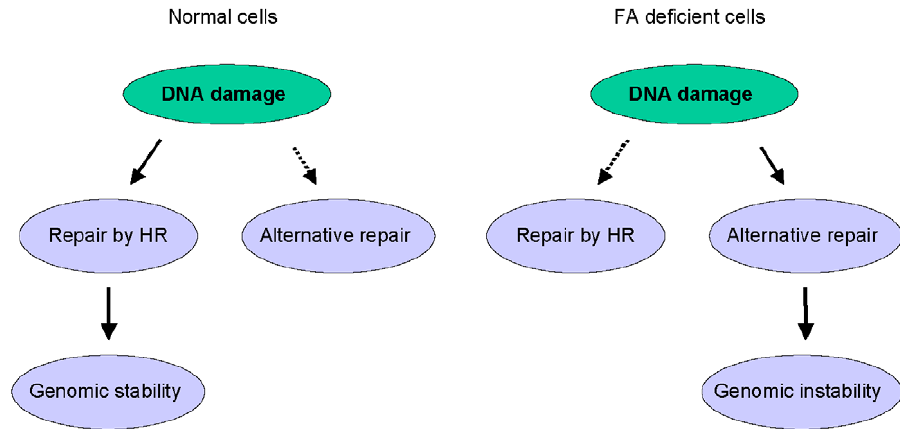
Fig. 8. In normal cells the FA pathways initiates the homologous recombination pathway to ensure correct repair of a DNA cross-link. The alternative, error-prone pathways, only play a minor role. In an FA-deficient cell, homologous recombination can no longer be utilized; therefore the alternative, error-prone pathways, such as NHEJ, come into action. This situation leads to genomic instability and cell